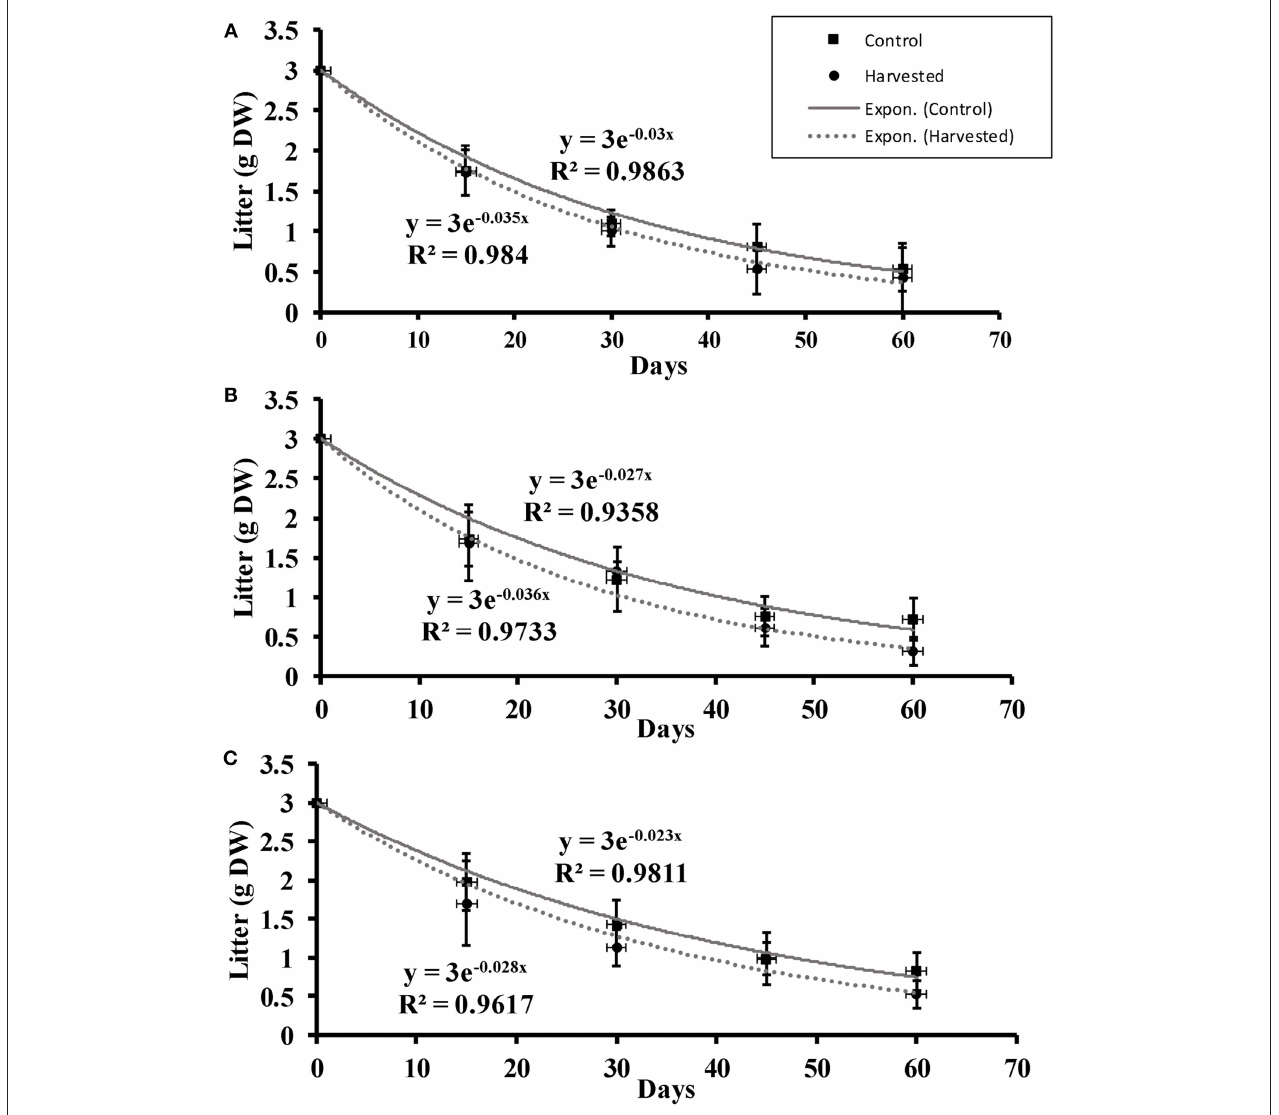
FIGURE 5 | Litter decomposition (mean ± 95% CI) over a two-month period at (A) 5cm, (B) 10cm, and (C) 15cm depths in the harvested and control plots.